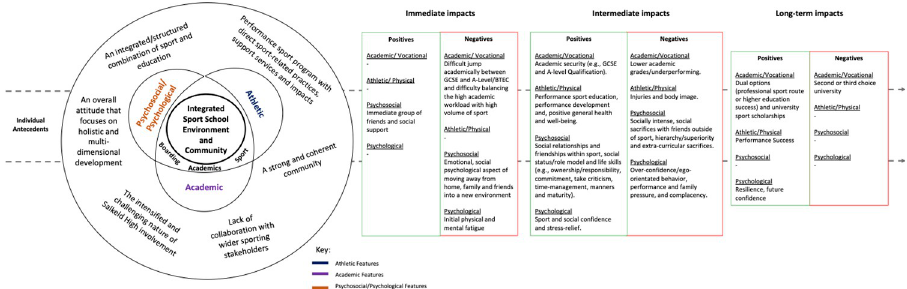
Fig 2. A conceptual thematic map of "Salkeld